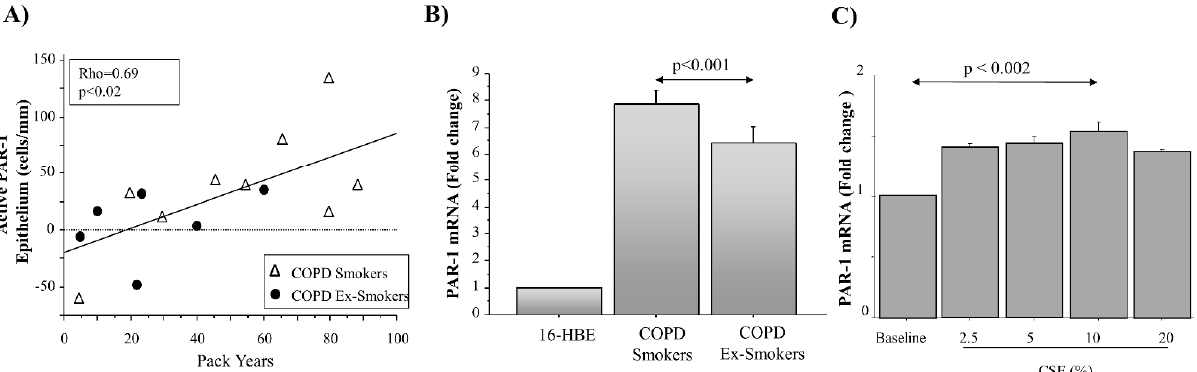
Figure 5. ( A ) Correlations between pack-years and PAR-1 active receptor immunoreactivity in epithelial cells from